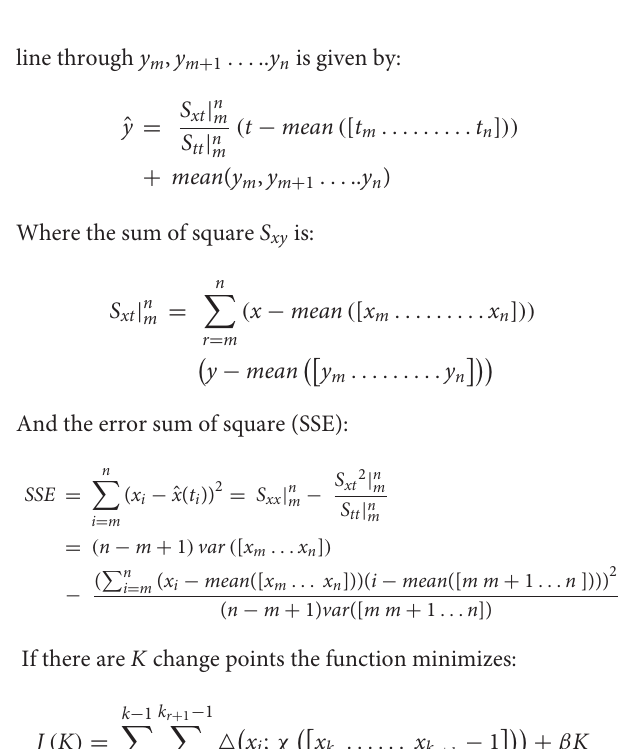
FIGURE 1 | (A) Recorded new cases of COVID-19 in Nepal and India, (B) recorded new deaths of COVID-19 in Nepal and India. The y -axis is in log scale to make the cases visible.